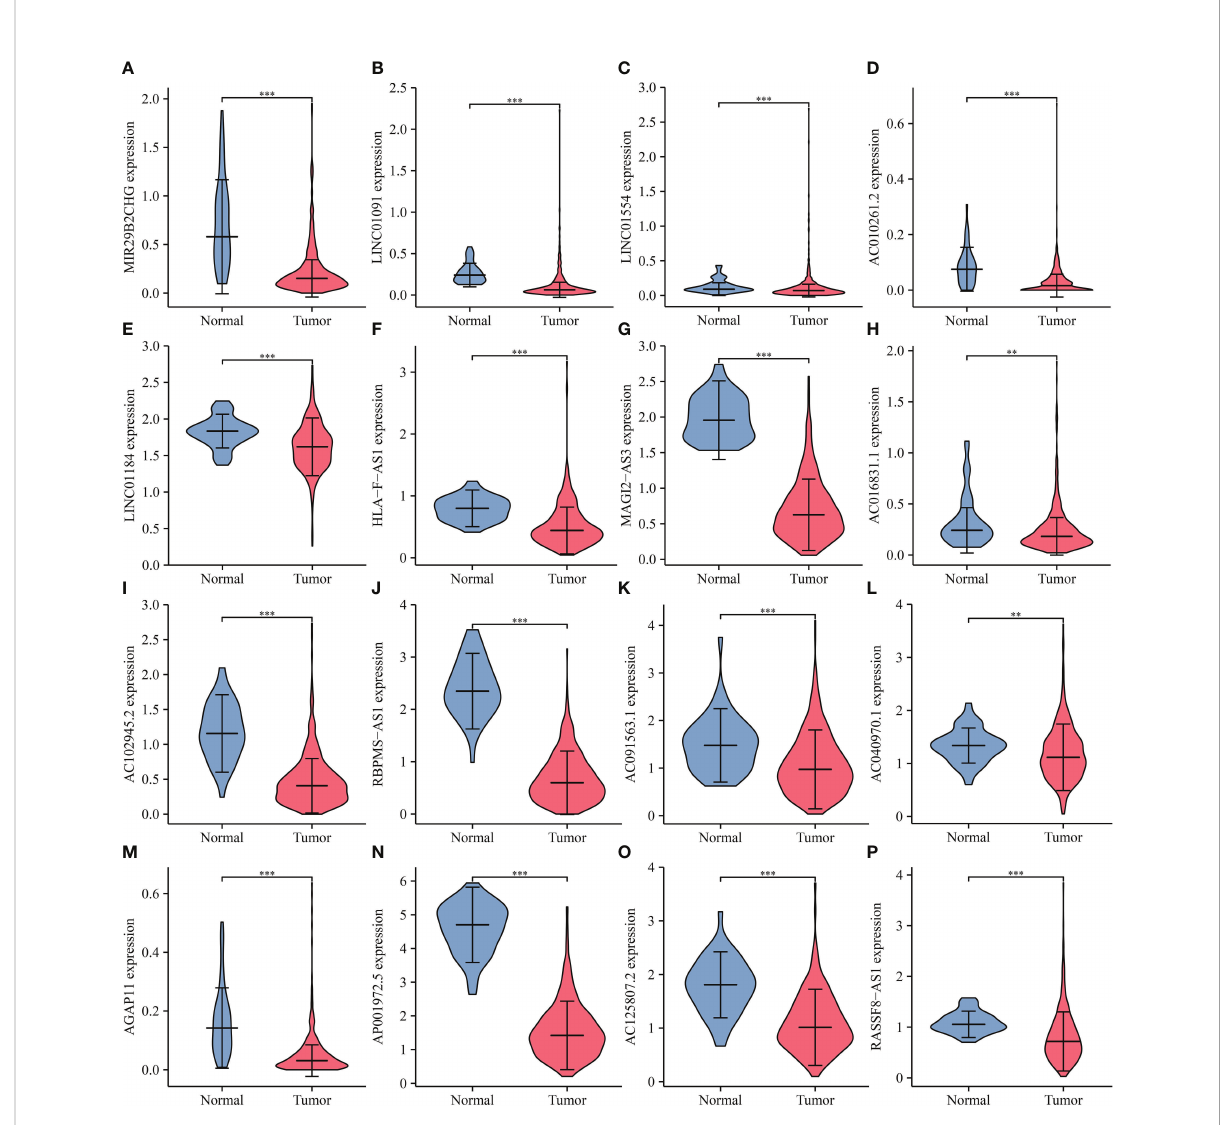
FIGURE 13 miR-128-3p-related lncRNA expression levels in LUSC. (A) MIR29B2CHG; (B) LINC01091; (C) LINC01554; (D) AC010261.2; (E) LINC01184; (F) HLA-F-AS1; (G) MAGI2-AS3; (H) AC016831.1; (I) AC102945.2; (J) RBPMS-AS1; (K) AC091563.1; (L) AC040970.1; (M) AGAP11; (N) AP001972.5; (O) AC125807.2; (P) RASSF8-AS1. LUSC, lung squamous cell